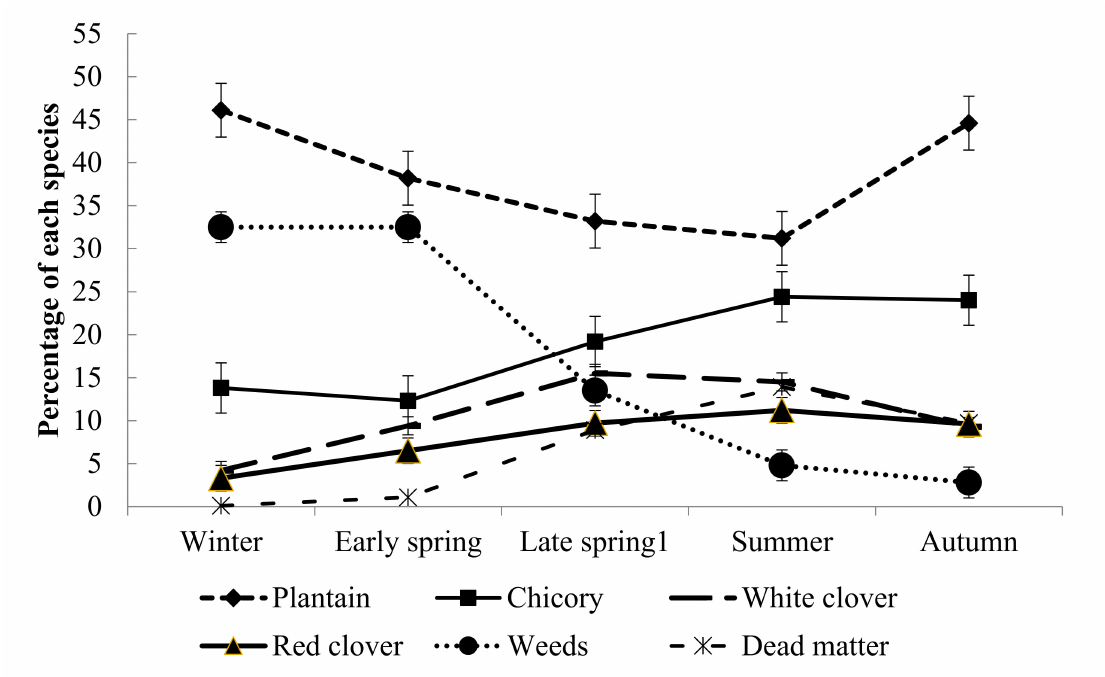
Figure 3. Botanical composition (%) within each season in the chicory mix. Late spring 1 and early summer. Vertical bars are ±